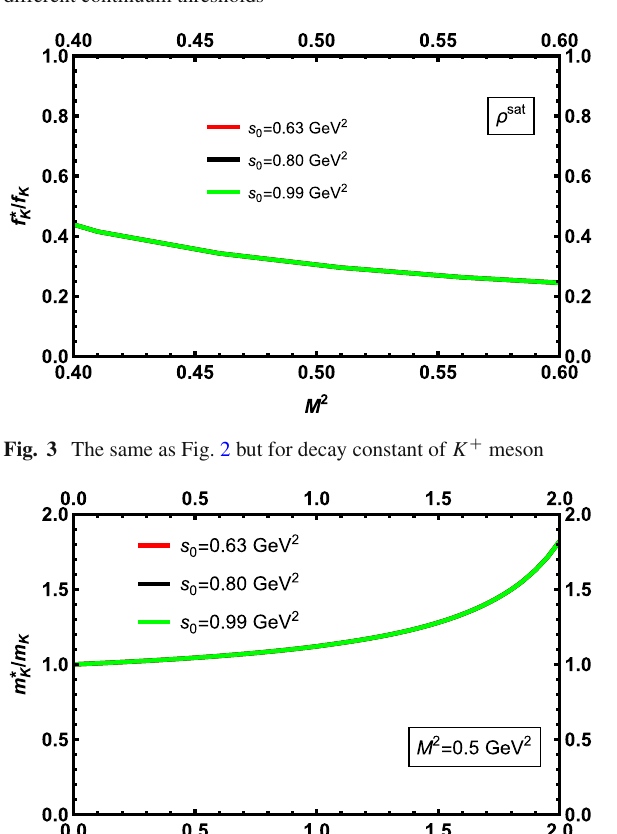
Fig. 2 Variation of the ratio of the in-medium to vacuum mass for K + meson with respect to Borel mass parameter at saturation density and different continuum thresholds